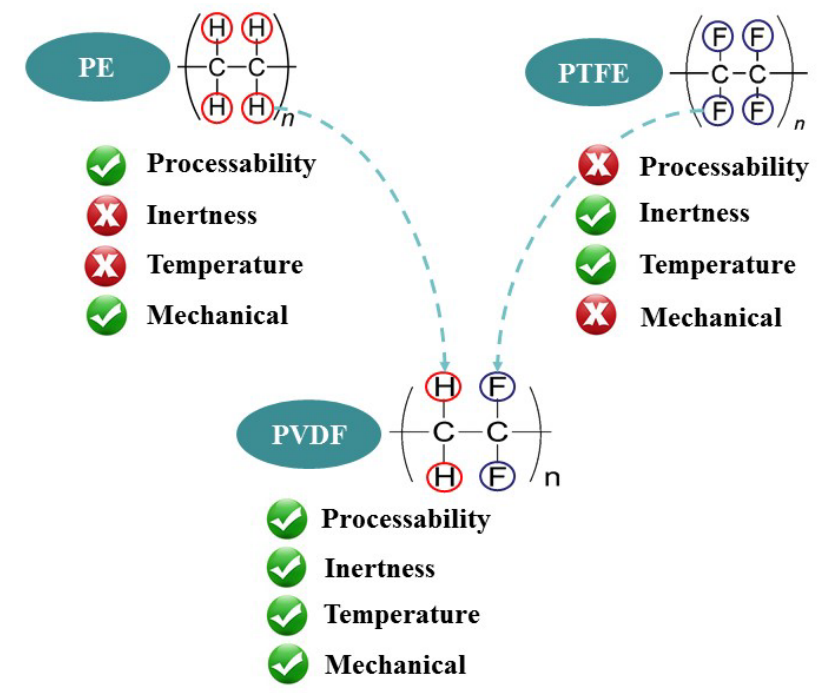
Figure 10. PVDF performance diagram.